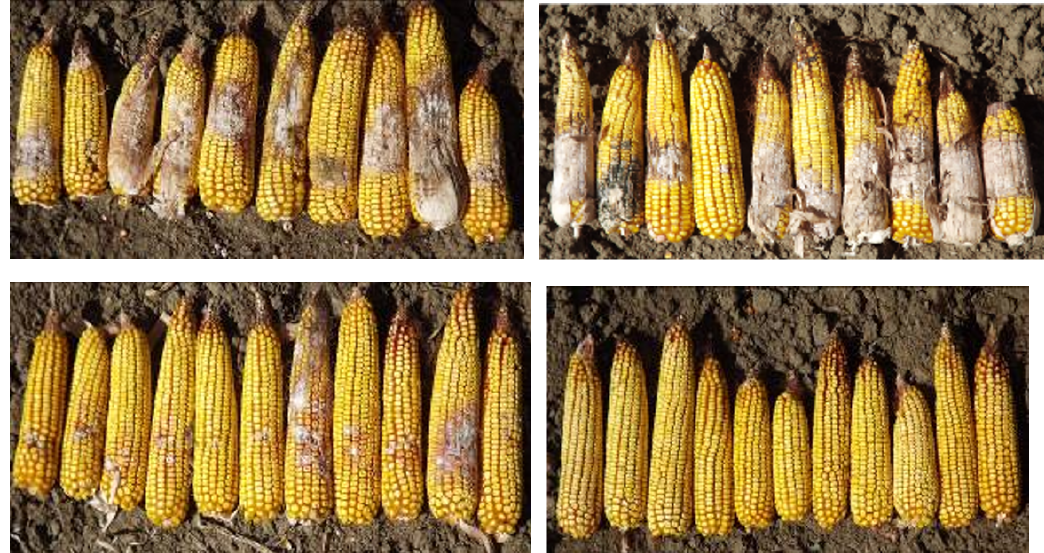
Figure 4. Resistance of hybrid SBL1 against different Fusarium spp. Toothpick method, kernel resistance. ( Left upper ): F. graminearum , ( right upper ): F. culmorum , ( left lower ): F. verticillioides, ( right lower ): naturally infected control.